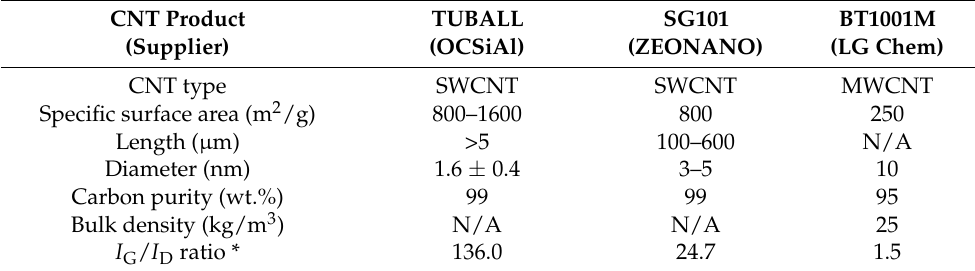
Table 1. Properties of CNT products (data were obtained from the